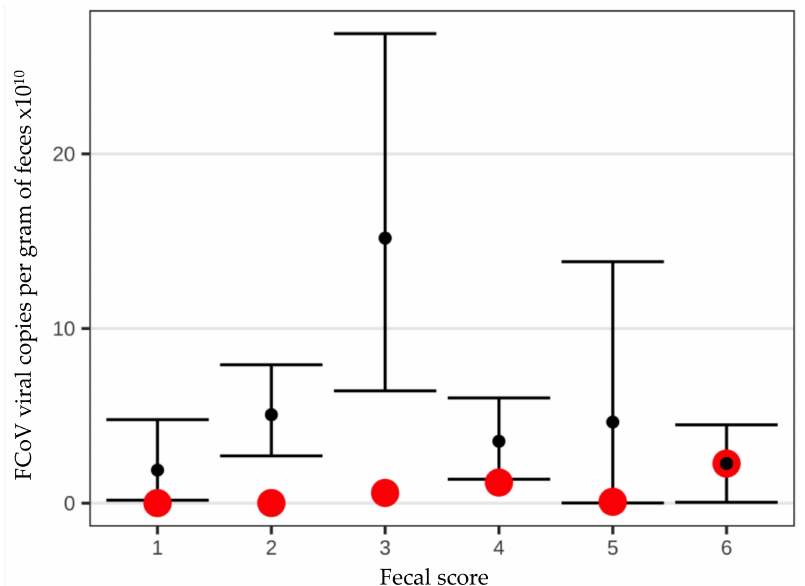
Figure 3. Bootstraps demonstrating no correlation between fecal score and fecal feline coronavirus (FCoV) load in viral copies per gram (g) of feces. Black points represent the mean fecal FCoV load in viral copies per g of feces. The 95% confidence intervals for the mean were calculated via the basic nonparametric bootstrap without assuming normality. Red points represent the median fecal FCoV load in viral copies per g of feces.